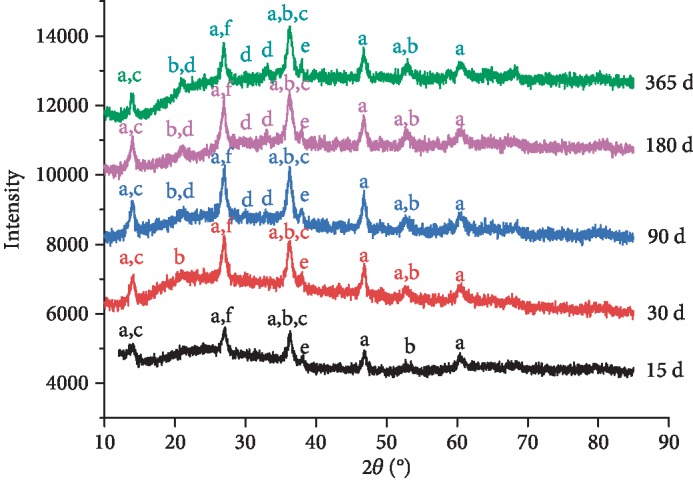
XRD spectra of the corrosion products of the Q235 carbon steel samples exposed at different periods in Chengdu station: (a) γ-FeOOH, (b) α-FeOOH, (c) Fe(OH)3, (d) Fe3O4, (e) γ-Fe2O3, and (f) FeSO4·nH2O.